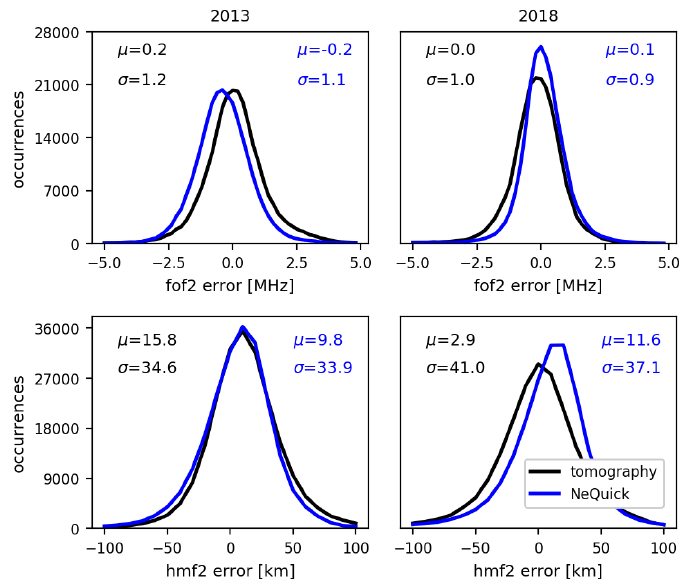
Figure 8. Histograms of foF2 and hmF2 errors from tomography and NeQuick when compared to ionosonde data for 2013 ( left panels ) and 2018 ( right panels ). The graph also shows model performance in terms of the overall mean ( µ ) and standard deviation ( σ ) of the